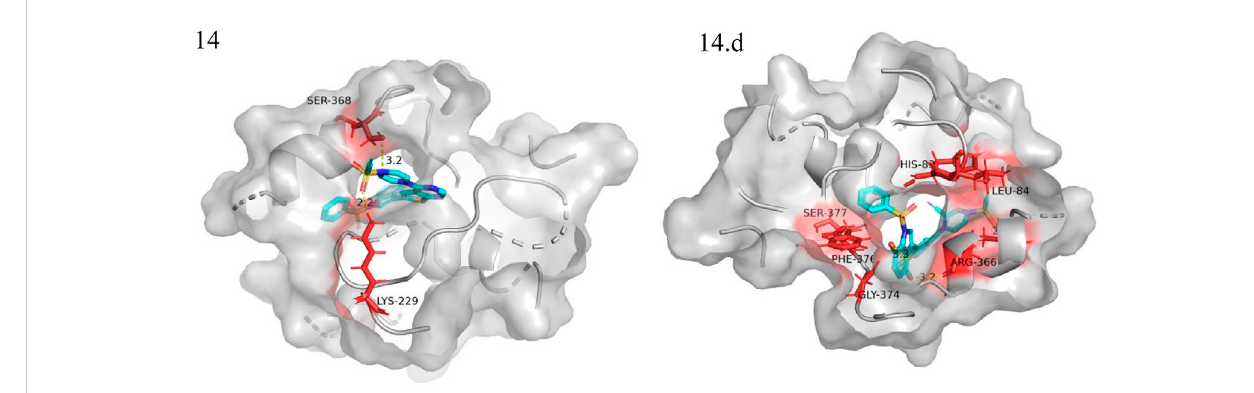
FIGURE 8 Docking experiments of compoud 14, 14.d with retinoblastoma targets (VEGFR3 homology model in the PDB format can be found in the Additional fi